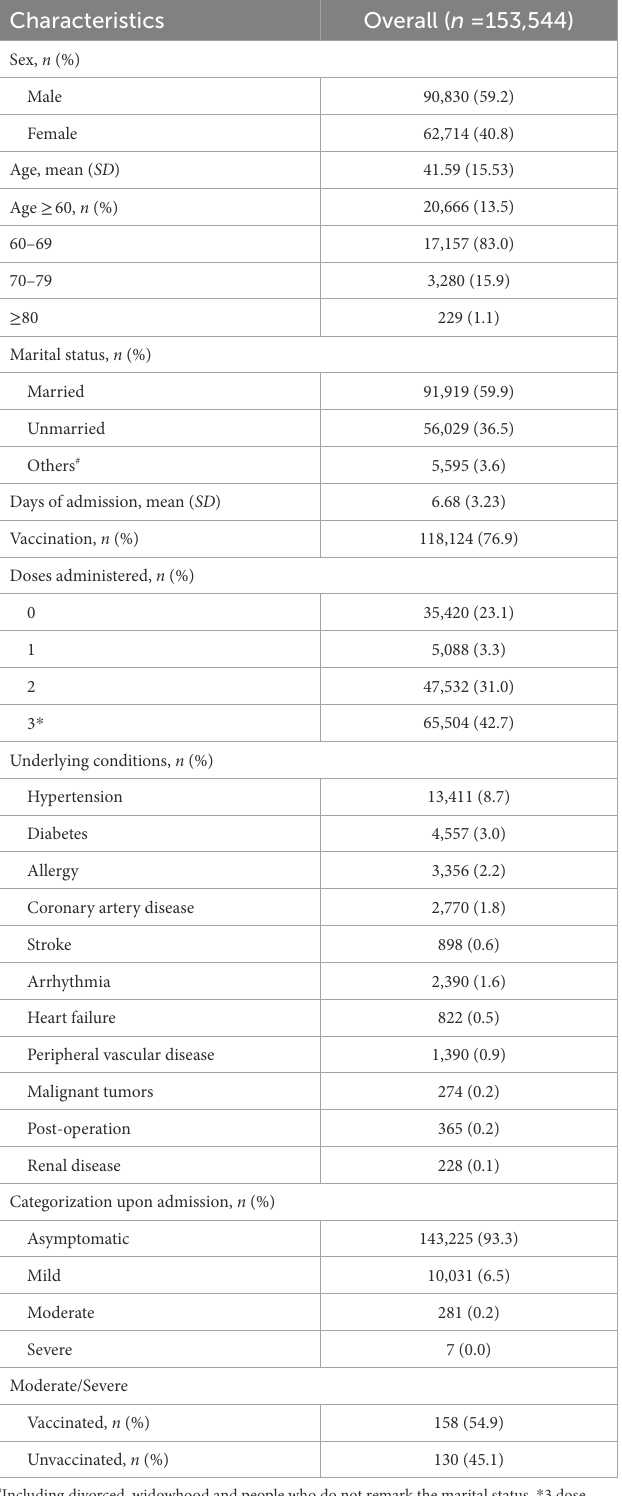
TABLE 1 Baseline characteristics.